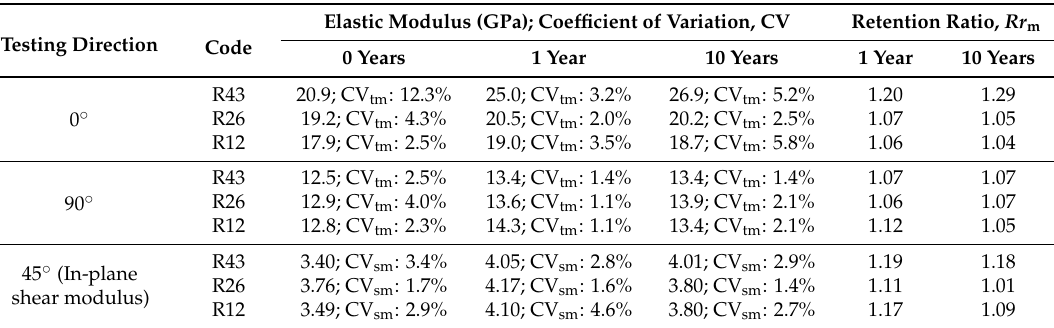
Table 6. Elastic modulus of unpainted specimens with retention ratios.